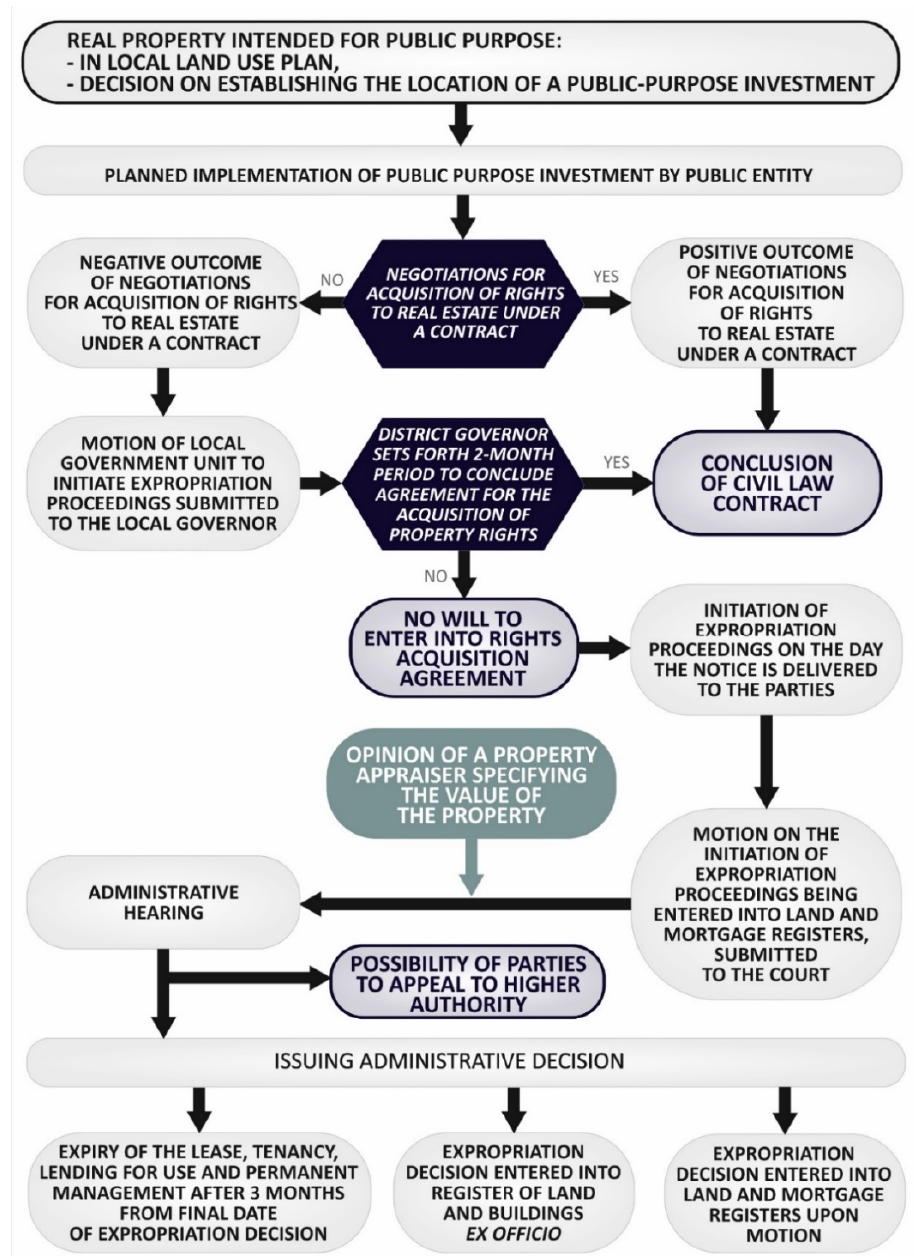
Figure 1. Real estate expropriation procedure in force in Poland. Source [19].